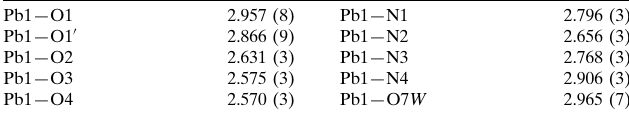
Selected bond lengths (A˚ ).